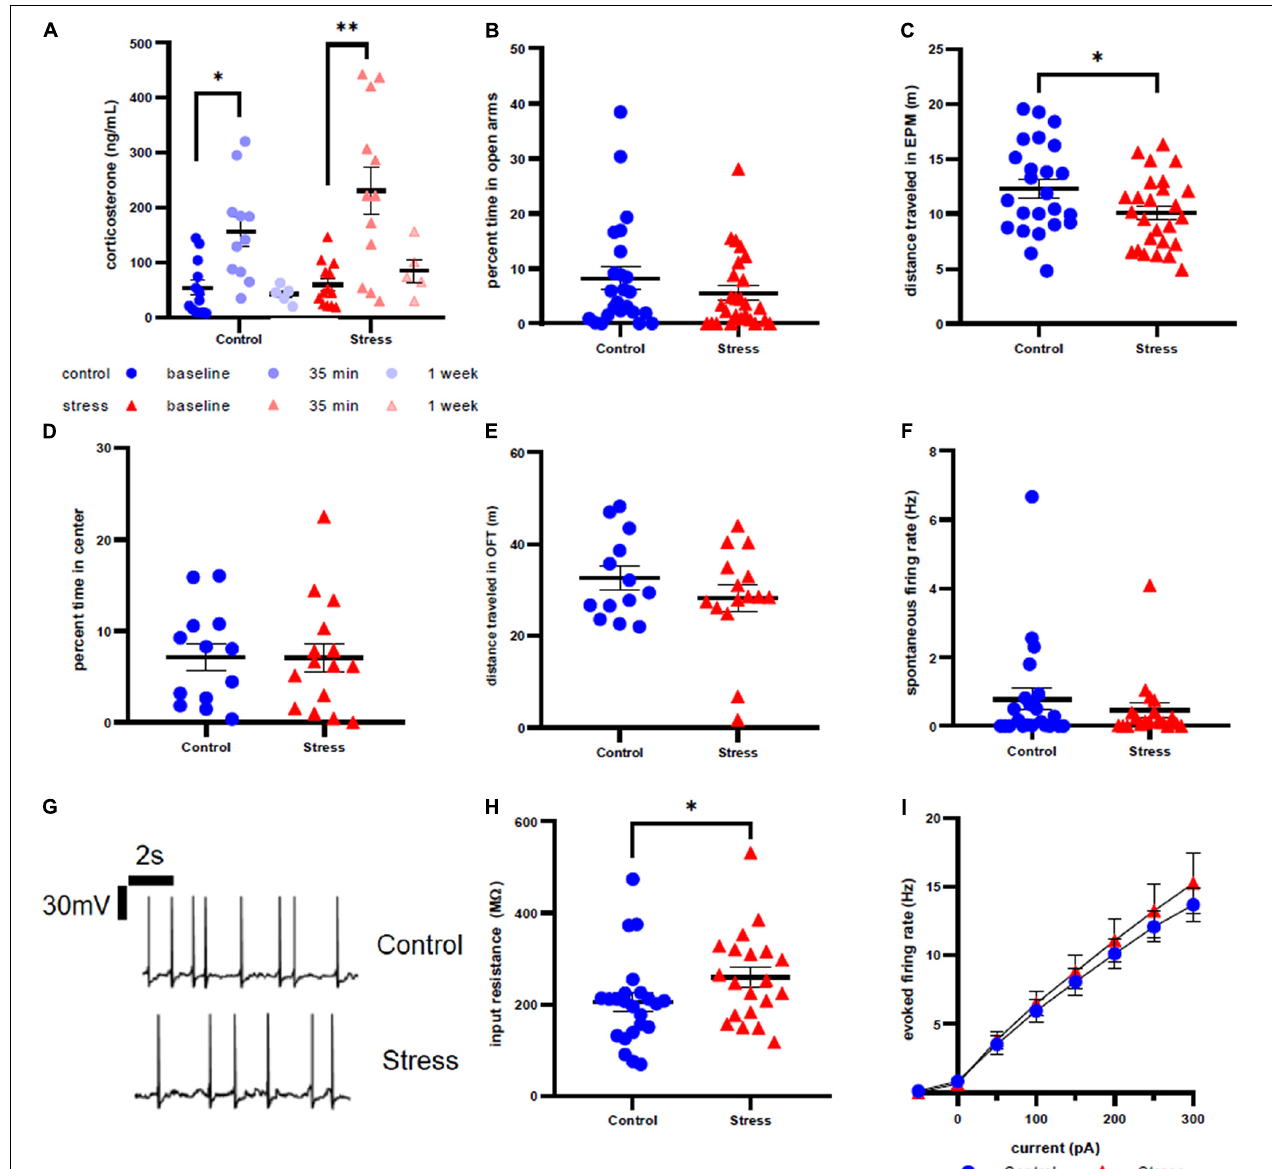
FIGURE 5 | Stress response in adult male rats. (A) Serum corticosterone concentration is higher 35 min after stress compared to baseline and 35 min after control compared to baseline. (B) There is no effect of stress on time spent in open arms of the elevated plus maze immediately after stress or control conditions. (C) Stress decreases distance traveled in the elevated plus maze immediately after stress or control conditions. (D) There is no effect of stress on time in the center of the open field test one week after stress. (E) There is no effect of stress on distance traveled in the open field test one week after stress. (F) There is no effect of stress on spontaneous firing rate of LC neurons one week after stress. (G) Representative traces for spontaneous firing in control (top) and stress (bottom) groups. (H) There is a significant increase in input resistance of LC neurons one week after stress. (I) There is no effect of stress on the excitability of LC neurons 1 week after stress. ∗ p < 0.05; ∗∗ p < 0.01.